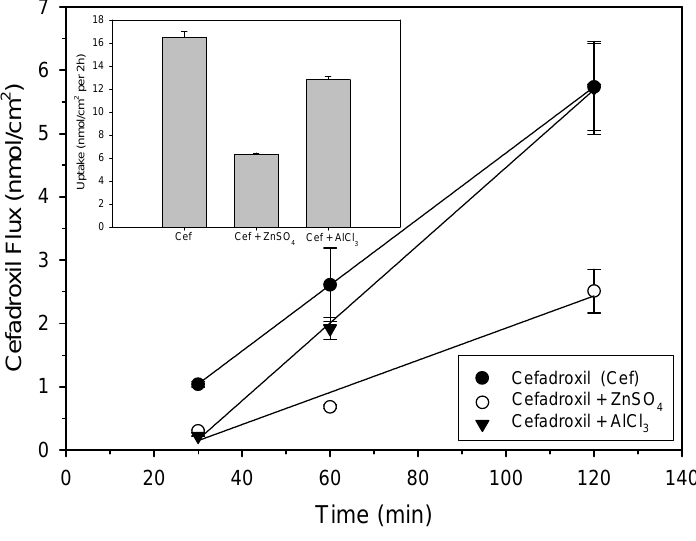
Figure 3. Effect of ZnSO and AlCl on total transepithelial flux and intracellular 4 3 accumulation of cefadroxil at Caco-2 cell monolayers. Cefadroxil (1 mM) was added to the apical (donor) compartment of the Transwell ® chambers in uptake buffer (pH 6.0) with or or AlCl . After the time intervals indicated, samples were taken from without 1 mM ZnSO 4 3 the receiver compartment (pH 7.5) and replaced with buffer. Inset: Cefadroxil content in cells on filters cut out of the plastic inserts after the flux measurements. The amount of cefadroxil in the basolateral compartment and in the cells was measured with HPLC. Data are shown as means ± S.E., n =